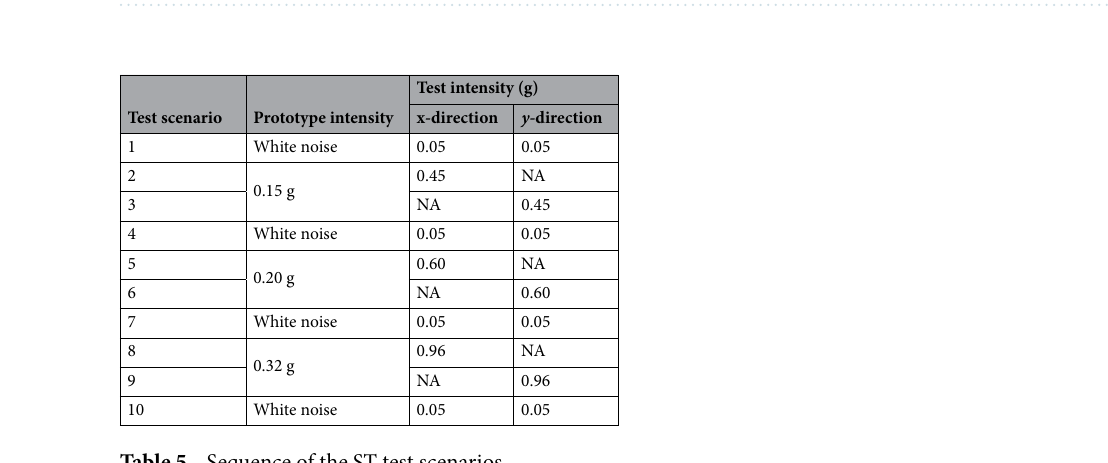
Table 5. Sequence of the ST test